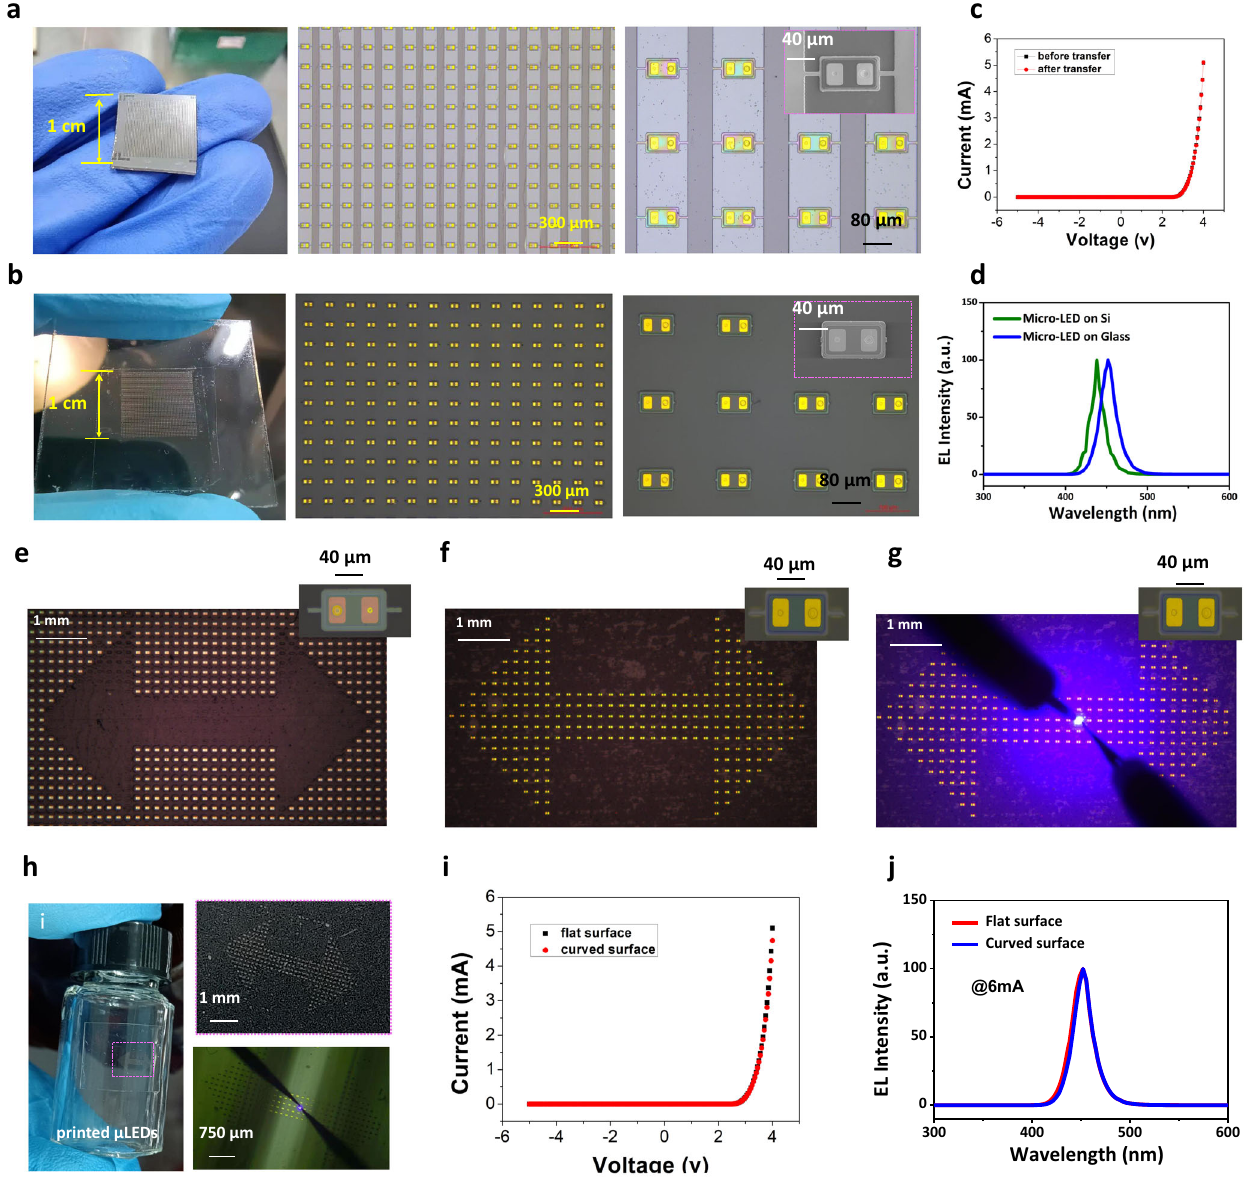
Fig. 6 Micro-LED transfer printing. a Optical images of tethered Micro-LEDs formed on a silicon substrate before transfer printing. b Optical images of Micro-LED arrays transfer printed to a glass substrate under different magni fi cations. Flood exposure time is 2.5 s. c I-V characteristics of the Micro-LED before transfer and after transfer. d EL spectra of the Micro-LED before transfer and after transfer. The injection current is 6 mA. e Optical image of the Micro-LEDs left on the original adhesive after selective transfer. f Optical image of the arrow-shaped Micro-LEDs selectively transferred onto a PET substrate, with a 1.5 s fl ood exposure and a 1.5 s masked exposure. g Emission image of the printed arrow-shaped Micro-LED array with one pixel switched on by probes. h Optical images of selectively printed arrow-shaped Micro-LEDs integrated onto the curvy surface of a glass bottle (Left, and top right), and the same array with one pixel switched on, after integration onto the curvy surface (bottom right). i I-V characteristics of the Micro-LED on a fl at substrate and a curvy substrate, j EL spectra of the Micro-LED on a fl at substrate and a curvy